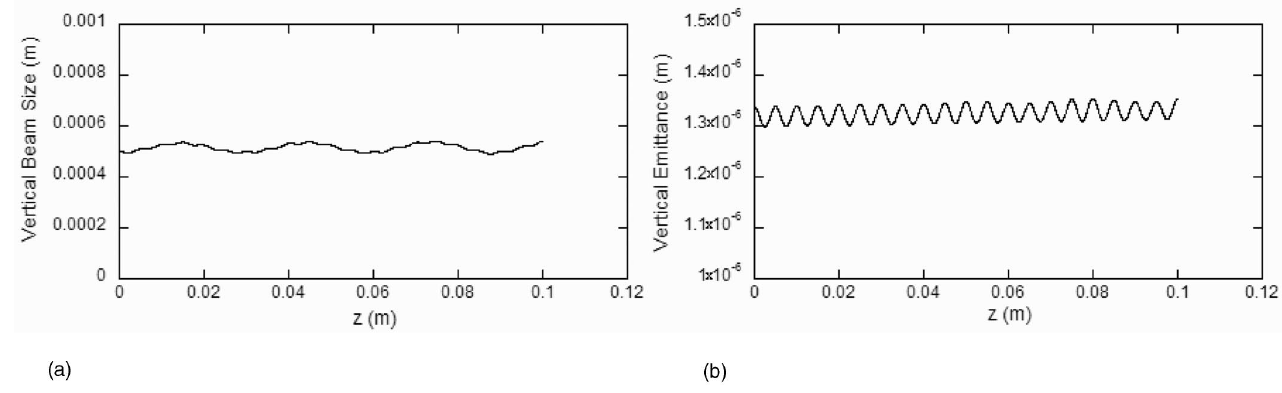
FIG. 4. (a) 4-times y beam size versus axial distance for a 90% wiggler, 10% PPM field split. (b) Normalized vertical emittance rms versus axial